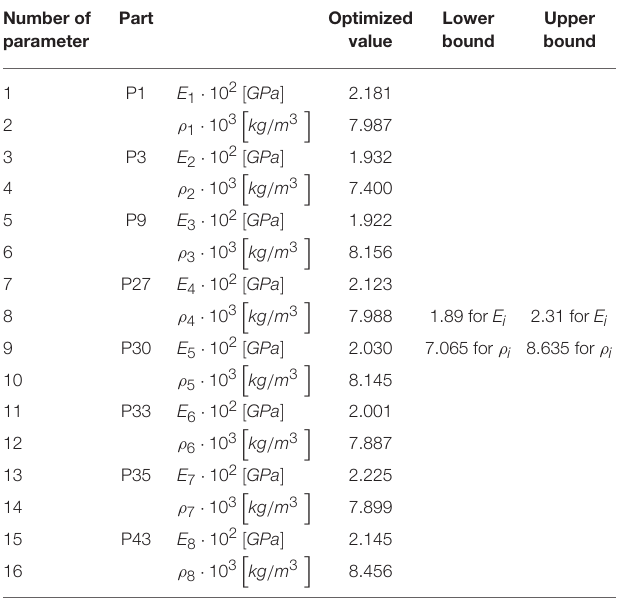
TABLE 2 | Optimized parameter values of material properties for rotor shaft and indicative blades of the intermediate pressure turbine. Number of